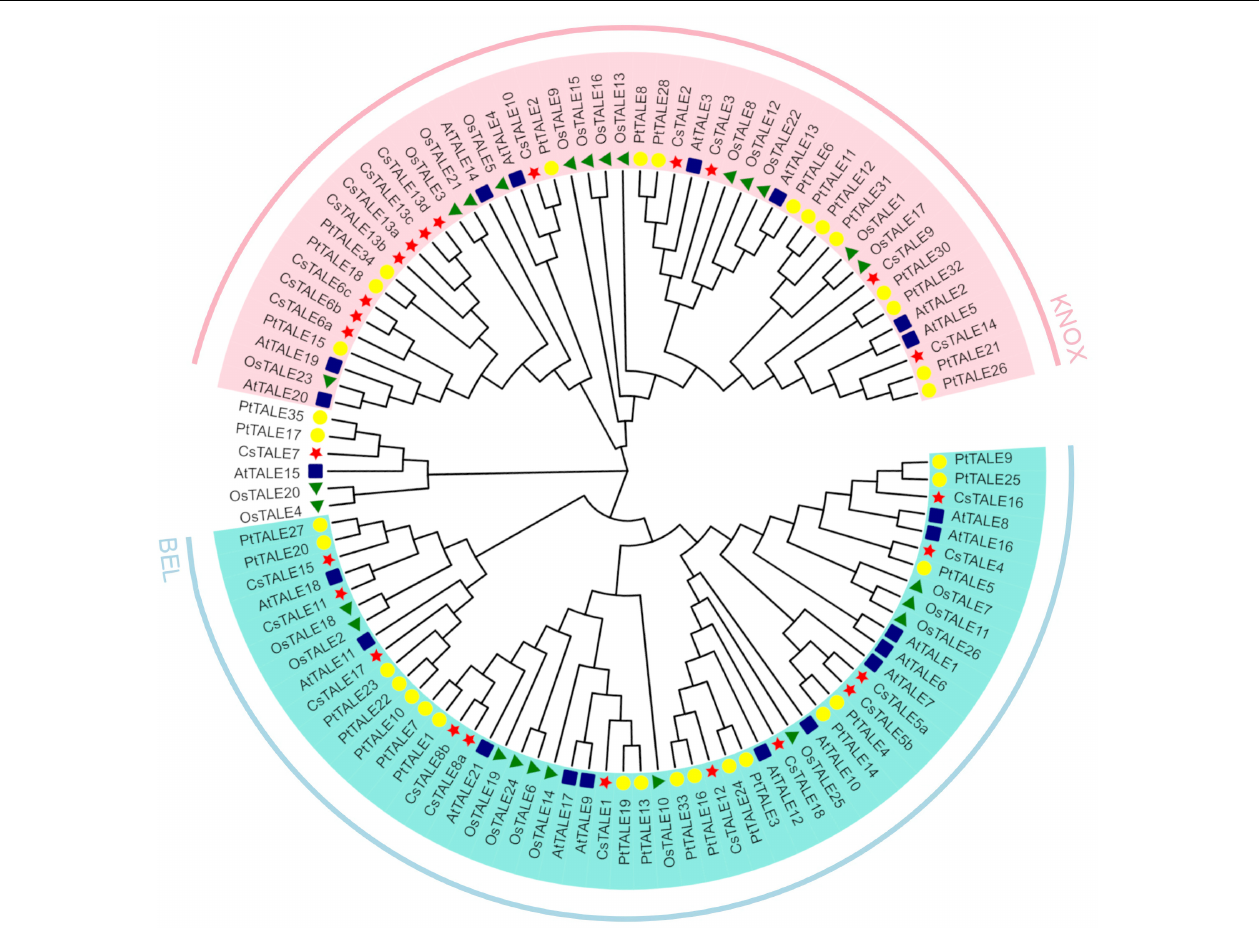
FIGURE 1 | Phylogenetic tree of Citrus sinensis , Arabidopsis thaliana , Oryza sativa, and Populus trichocarpa TALE proteins. The phylogenetic tree was constructed from amino sequences using MEGA-X v10.2.4 software by the neighbor-joining method with 1000 bootstrap replicates. The TALE proteins are clustered into 2 subgroups, marked by different colors. Red star indicates Citrus sinensis TALEs ( Cs TALE), blue square indicates Arabidopsis thaliana TALEs ( At TALE), green triangle indicates Oryza sativa TALEs ( Os TALE), and yellow circle indicates Populus trichocarpa TALEs ( Pt